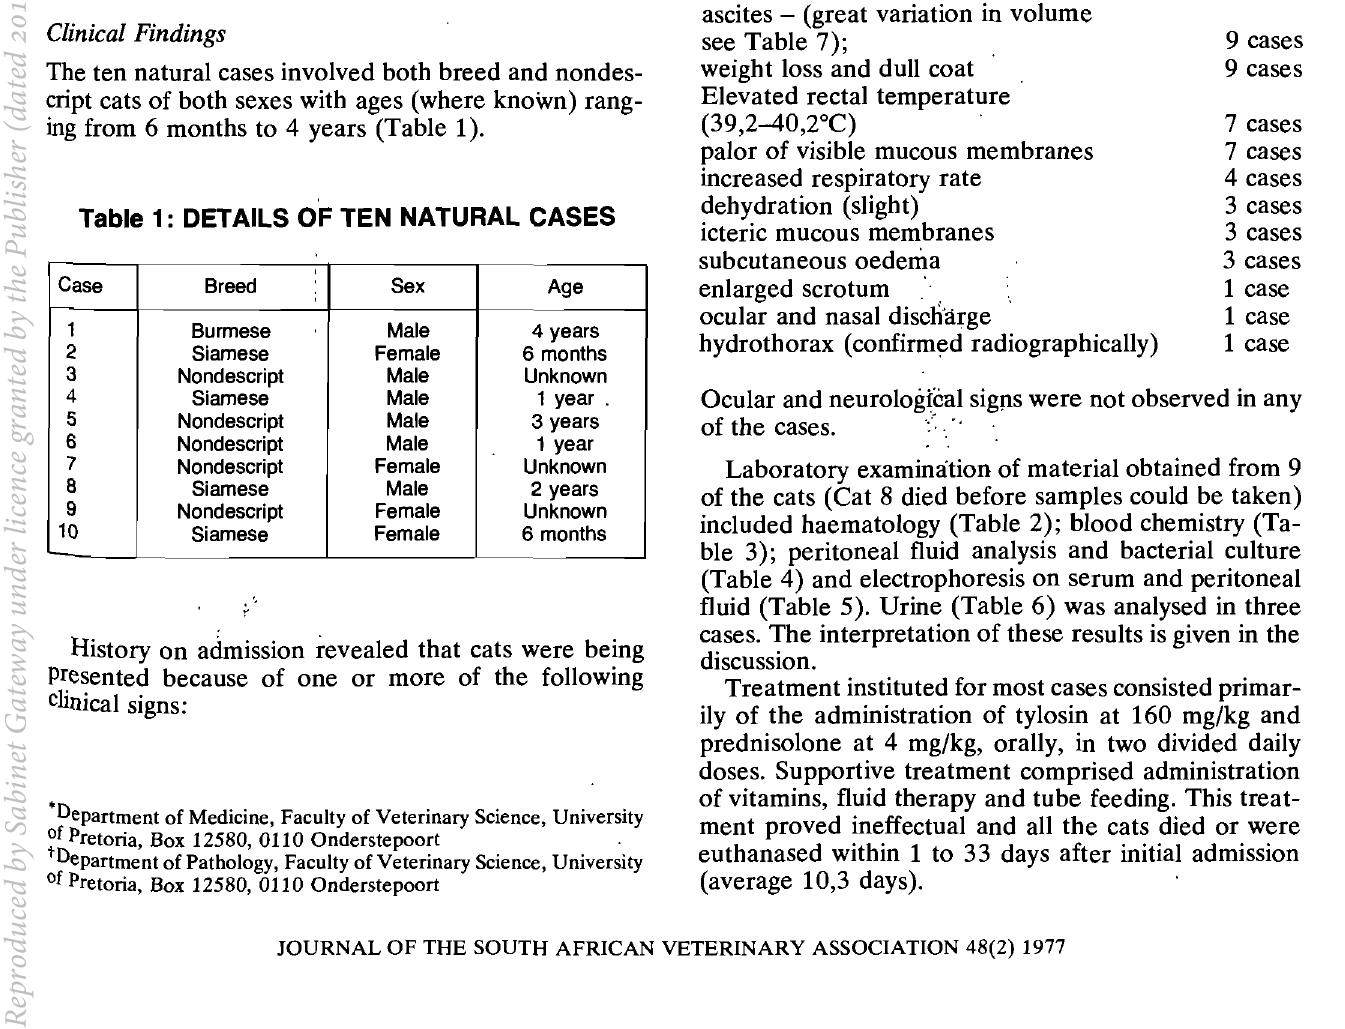
Table 1: DETAILS OF TEN NATURAL